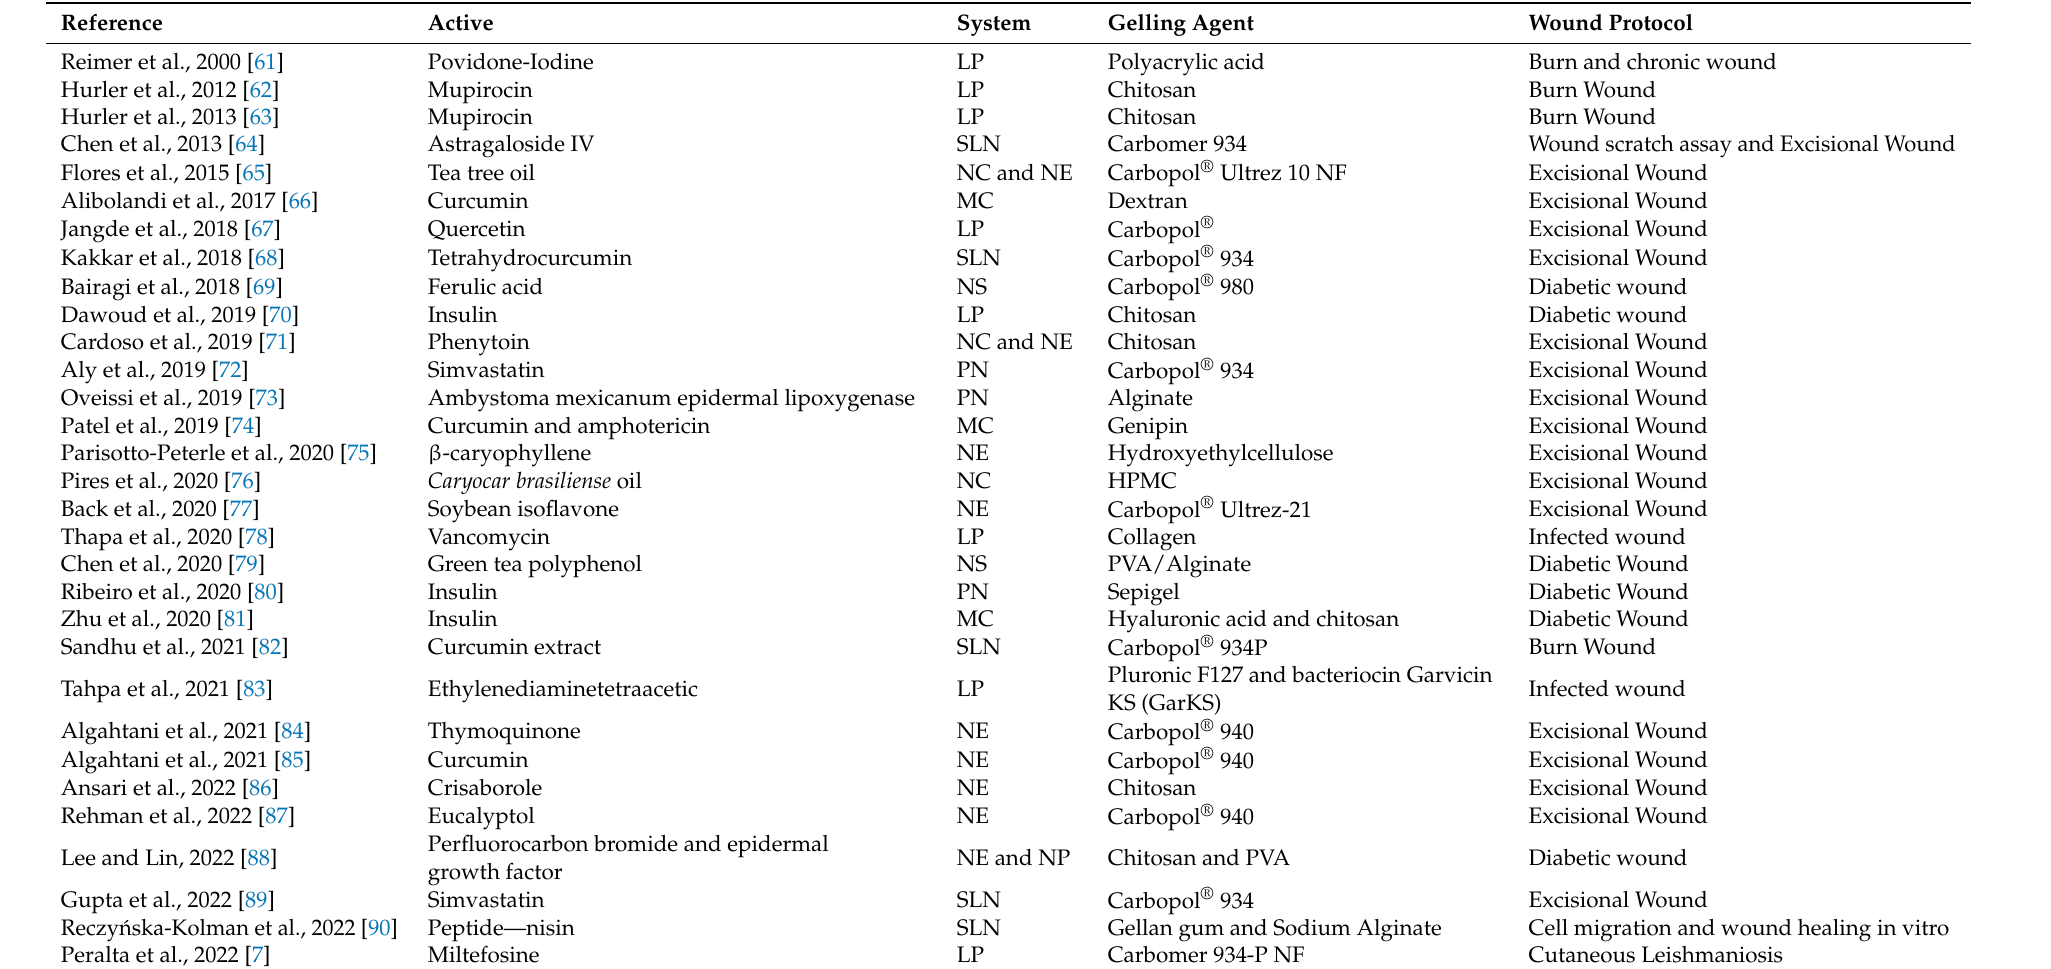
Table 1. General aspects of the studies included in the